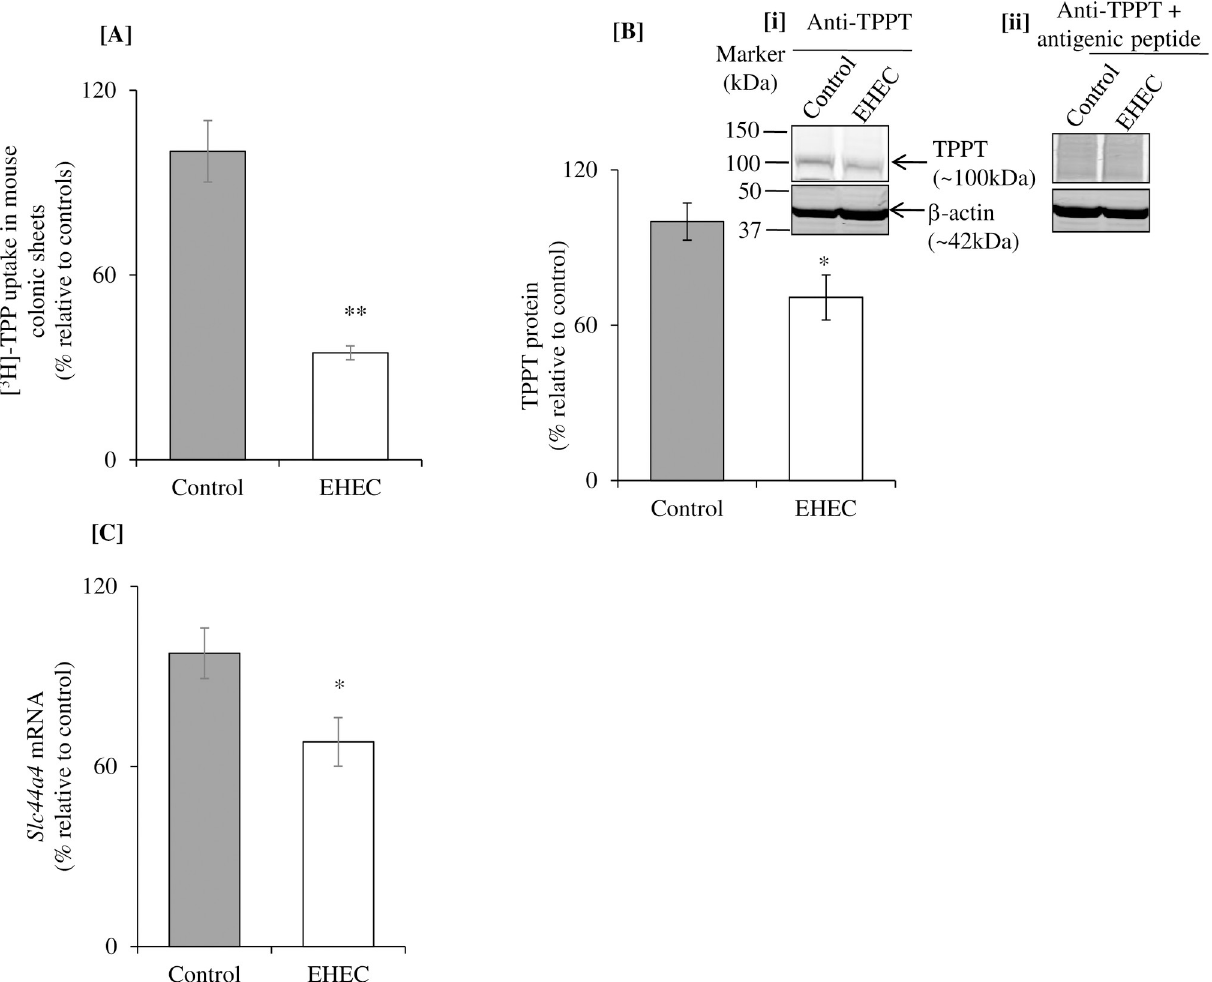
Fig 2. Effect of EHEC infection of mice in vivo on colonic carrier-mediated TPP uptake and on level of expression of TPPT. [A] Carrier-mediated [ 3 H]-TPP uptake was examined in colonic sheet of C57BL/6J male mice (8–10 week-old) infected with EHEC for 72 h. [B] Levels of TPPT protein expression was examined in EHEC infected mouse colonic tissue. The membranes were incubated with custom made anti-TPPT antibodies [i] and anti- TPPT antibodies pretreated with antigenic peptide [ii]. The antigenic peptide was used to show the specificity of the TPPT. [C] Levels of Slc44a4 mRNA expression was examined in EHEC infected colonic tissue. Data are mean ± SE of 3–4 pairs of mice. �� P < 0.01; � P < 0.05.